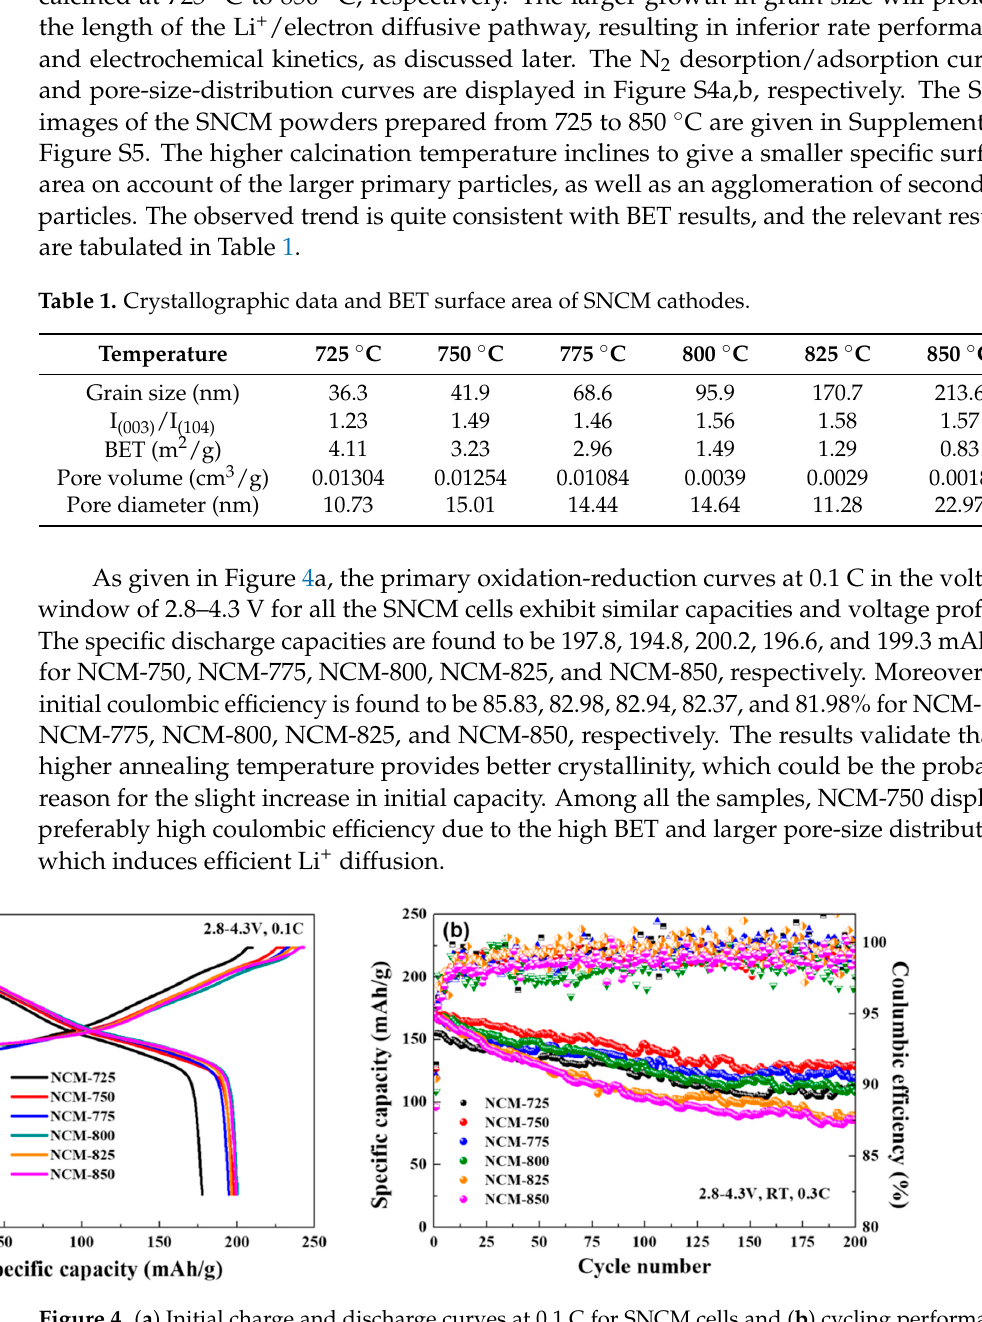
Figure 4. ( a ) Initial charge and discharge curves at 0.1 C for SNCM cells and ( b ) cycling performance of SNCM cells at 0.3 C rate (temperature, RT; voltage window, 2.8–4.3 V).